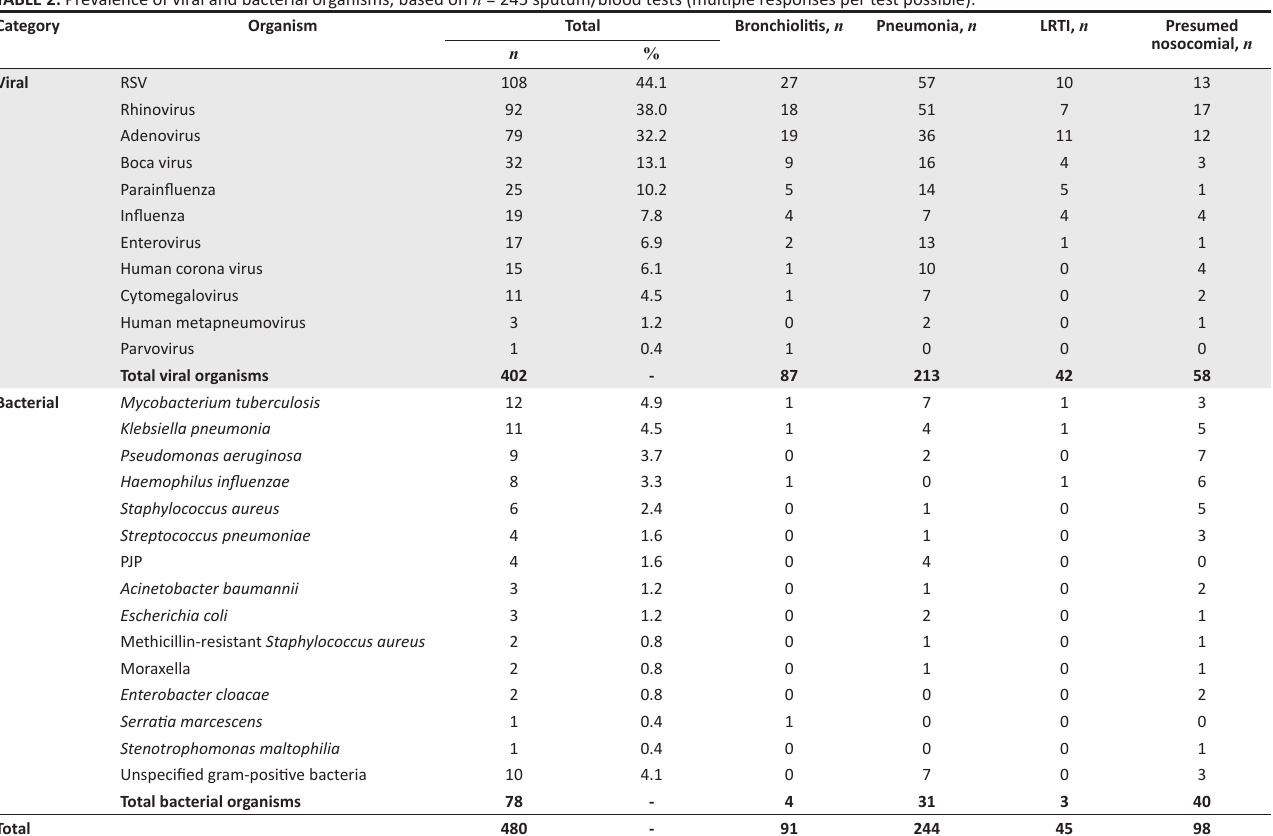
TABLE 2: Prevalence of viral and bacterial organisms, based on n = 245 sputum/blood tests (multiple responses per test possible). Category Organism